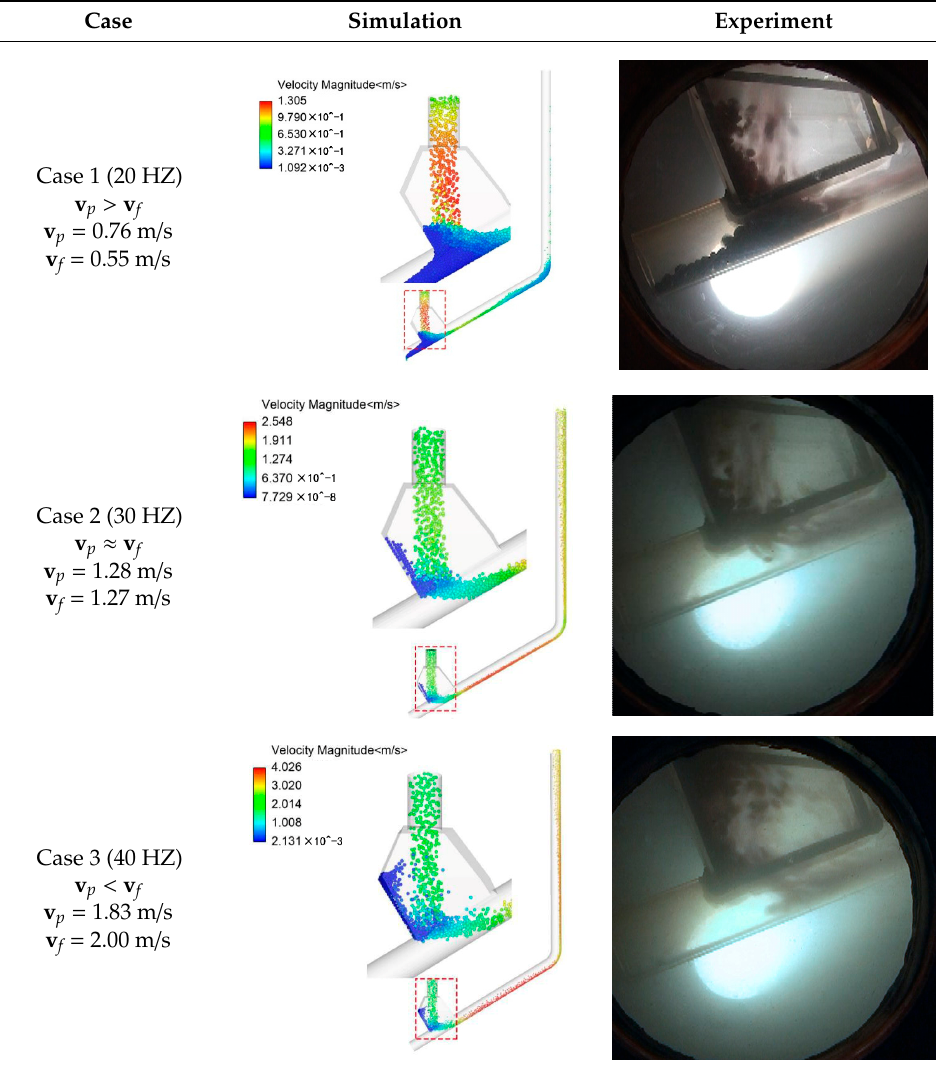
Figure 7. Comparison of the outlet flow rates obtained by the simulation and experiment.